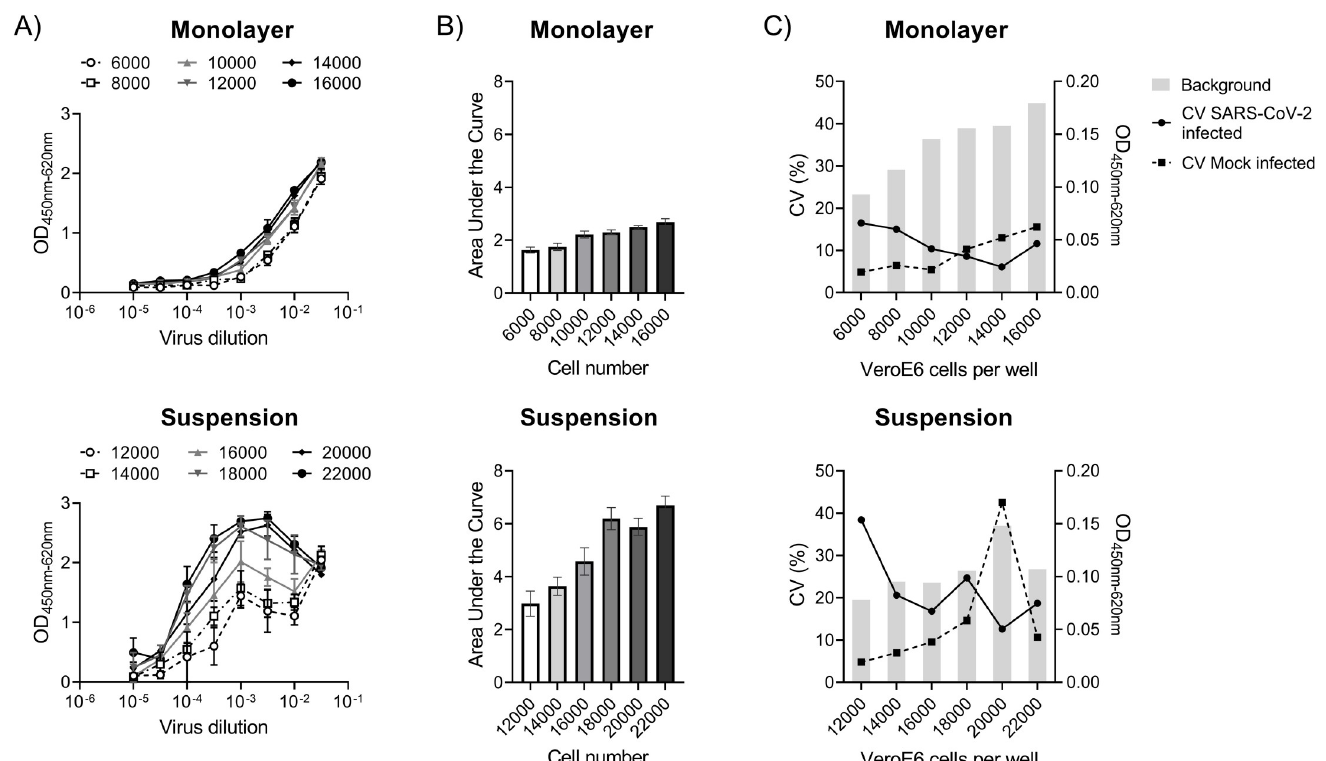
Fig 2. Effect of Vero E6 cell number and morphology on the relationship between SARS-CoV-2 nucleocapsid protein measured by ELISA and SARS-CoV-2 virus inoculum. Triplicate serial dilutions (0.5 log 10 -fold) of a Danish SARS-CoV-2 clinical isolate (early pandemic strain (lineage B.1)) was added to increasing numbers of Vero E6 cells in a monolayer or in suspension. The cell numbers indicated for the monolayer are as seeded the day prior to the infection. On the day of infection, the seeded cell numbers– 6000, 8000, 10000, 12000, 14000, and 16000 –increased to 12000, 14000, 16000, 18000, 20000, and 22000, respectively. The latter cell numbers were used for the infection of suspended cells to ensure a similar multiplicity of infection for the monolayers. (A) SARS-CoV-2 virus titration curve for different cell numbers infected in a monolayer and suspension. Symbols indicate the mean and error bars the standard deviation. (B) The overall SARS-CoV-2 nucleocapsid protein signal measured for the virus dilution series, expressed as area under the curve for the Log 10 decimal virus dilution and ELISA OD value as a measure of the magnitude of variance associated with changes in cell number (shown in A). Error bars represent the 95% confidence interval. (C) The percentage coefficient of variation (CV) for SARS-CoV-2 infected and mock infected cells as well as the background anti-SARS-CoV-2 nucleocapsid protein level measured for mock infected cells. For all experiments, ELISA primary antibody: rabbit mAb